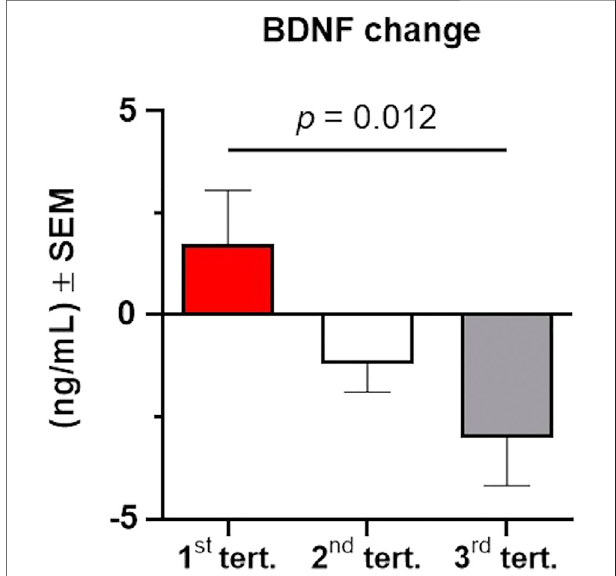
FIGURE 3 | Changes in serum BDNF levels from baseline to post- intervention depend on baseline levels of BDNF. The total cohort of participants was strati fi ed in three groups according to their baseline BDNF levels using tertiles. BDNF change was signi fi cantly higher ( p (cid:1) 0.012) in individuals with lower BDNF at baseline(1st tertile, shown in red) compared to individuals with higher levels of BDNF at baseline (2nd tertile, shown in grey; 3rd tertile, shown in grey). Data were analyzed using a one-way ANOVA with post-hoc Bonferroni adjustment. Error bars represent the